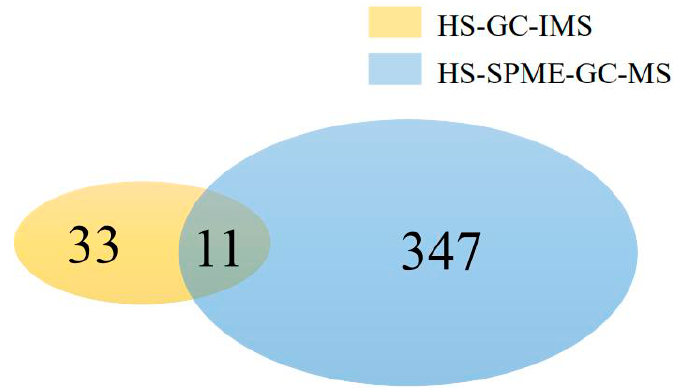
Figure 1. Venn diagram of volatile compounds detected via headspace gas chromatography-ion mobility spectrometry (HS-GC-IMS) and headspace solid-phase microextraction-gas chromatography-mass spectrometry (HS-SPME-GC-MS).